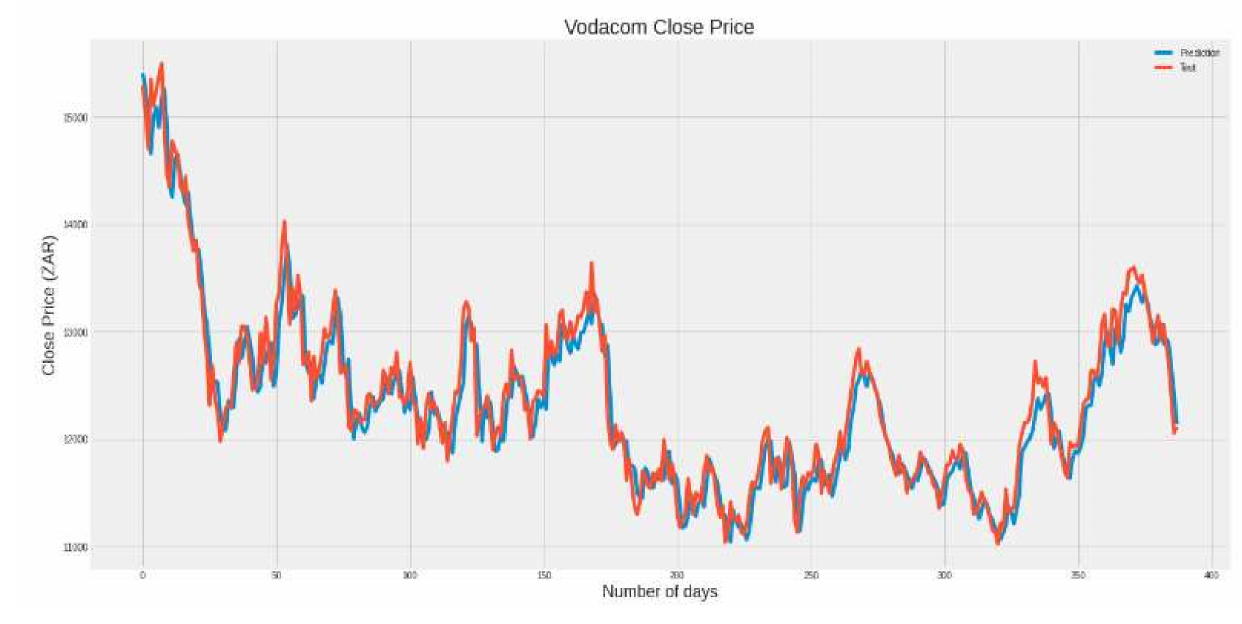
Figure 6. ConvLSTM Experiment 2.1. Table 5. Experiment 2.2 Results.